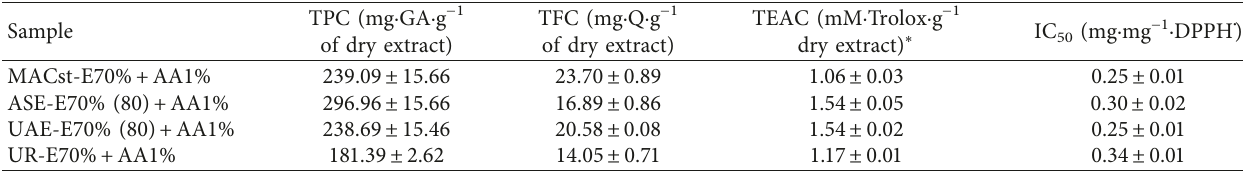
Table 8: Total phenolic content (TPC), total flavonoid content (TFC), antioxidant activity by the DPPH _ method, and free radical scavenging ability (ABTS + _ ) in different extracts (70% ethanol with addition of 1% acetic acid) from Tilia L. flowers.